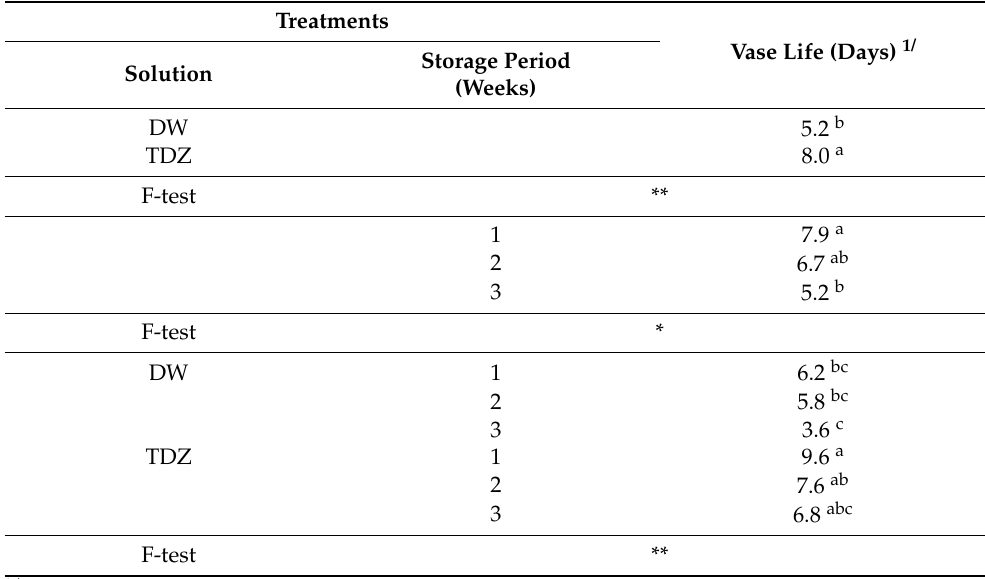
1/ Means within the same column with different letters represent significant differences between treatments accord- ing to Duncan’s multiple range test (DMRT). Asterisks represent significant differences in variance at p < 0.01